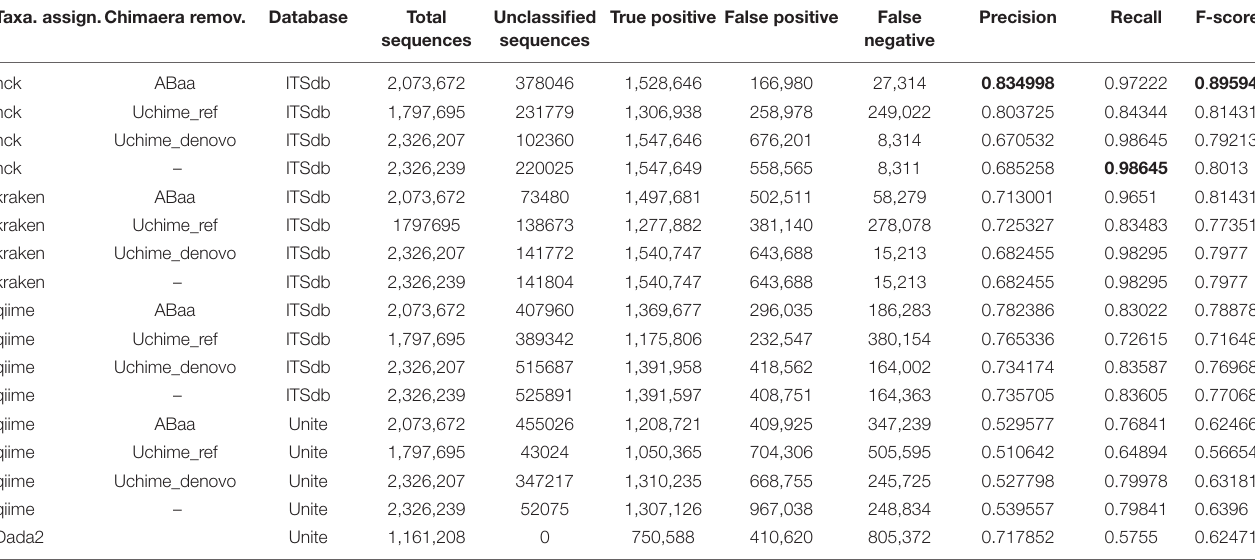
*Sequence filtered with the corresponding method and cleaned. TABLE 3 | Precision, recall, accuracy, and F-score performance of HCK and ABAA version other tested combination of chimaera detection and taxonomy assignment methods. Taxa. assign.Chimaera remov.